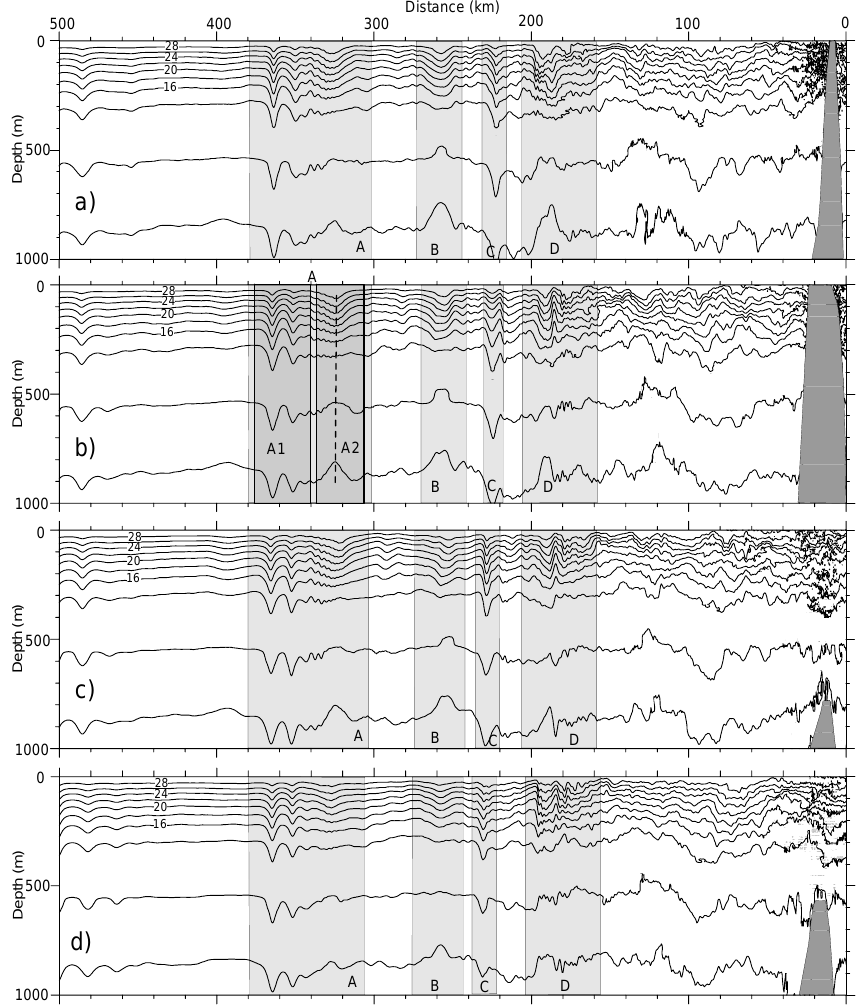
Fig. 4. Model predicted temperature fields after five tidal periods. Panels (a–d) correspond to similar cross-sections shown in Fig. 3. Fragments A,B,C and D represent similar wave fragments but at different